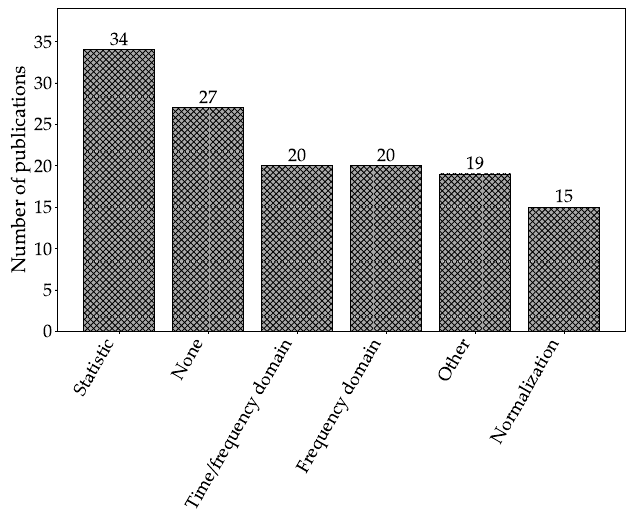
Figure 23. Feature extraction techniques of all the